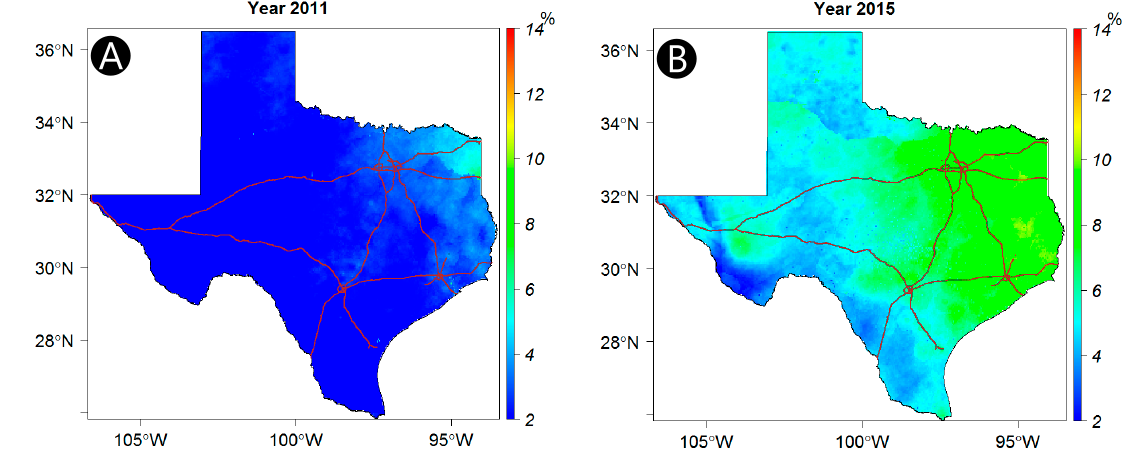
Figure 5. Spatial distribution of the annual frequency of hourly precipitation of the ( A ) driest (2011) and ( B ) wettest (2015) year in Texas over the study period.